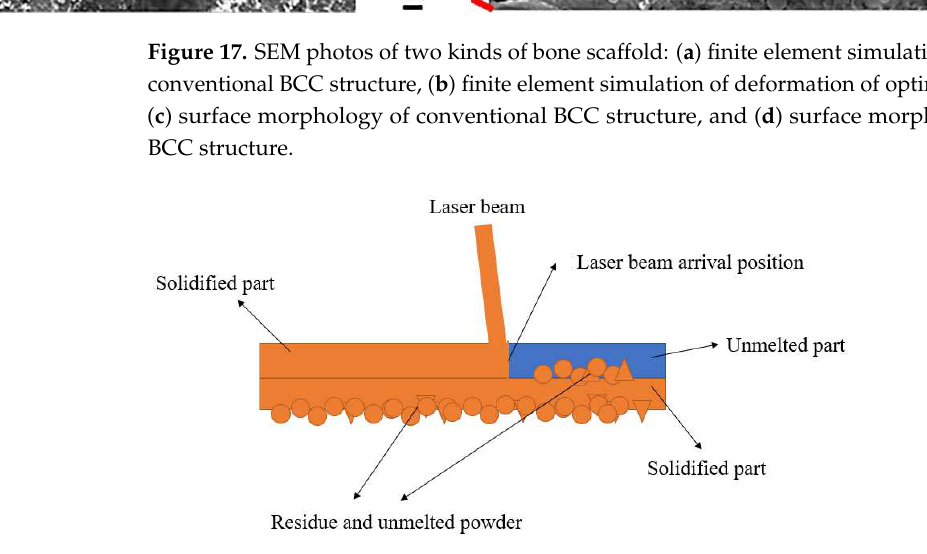
Figure 18. Schematic diagram of overhanging section additive manufacturing principle. It has been found that the surface orientation of a unitary column has a considerable effect on surface roughness and that a greater thermal gradient in a unitary column with